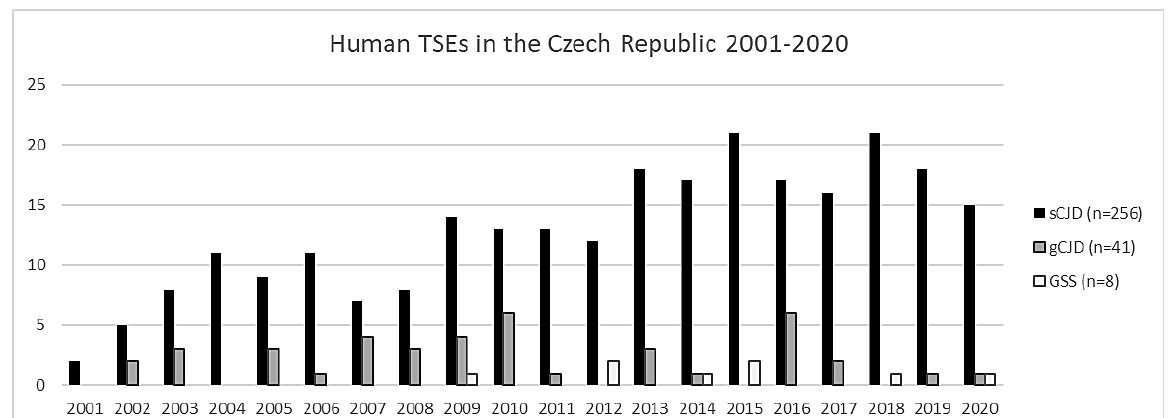
Figure 2. Number of patients who died with neuropathologically confirmed diagnose of prion disease in the Czech Republic (2001–2020). The legend shows the total number of cases for each type of prion disease. Table 5. Autopsy findings of non-prion diseases from brain tissue samples described as possible/probable CJD (2001– 2020).